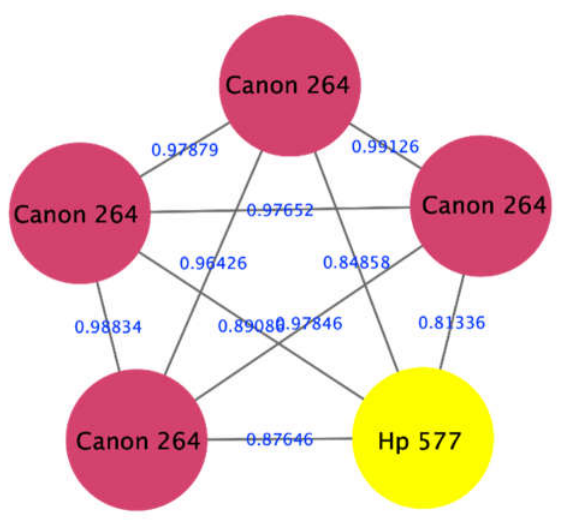
Figure 5. Visualization of a network consisting of five nodes, four of them representing spectra from the laser printer Canon mf264 (red nodes), while the fifth one represents a spectrum from the Inkjet printer HP 577 (yellow node).